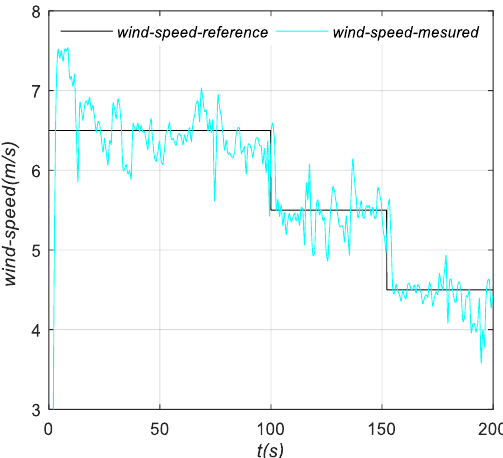
Figure 18. Wind velocity profile.